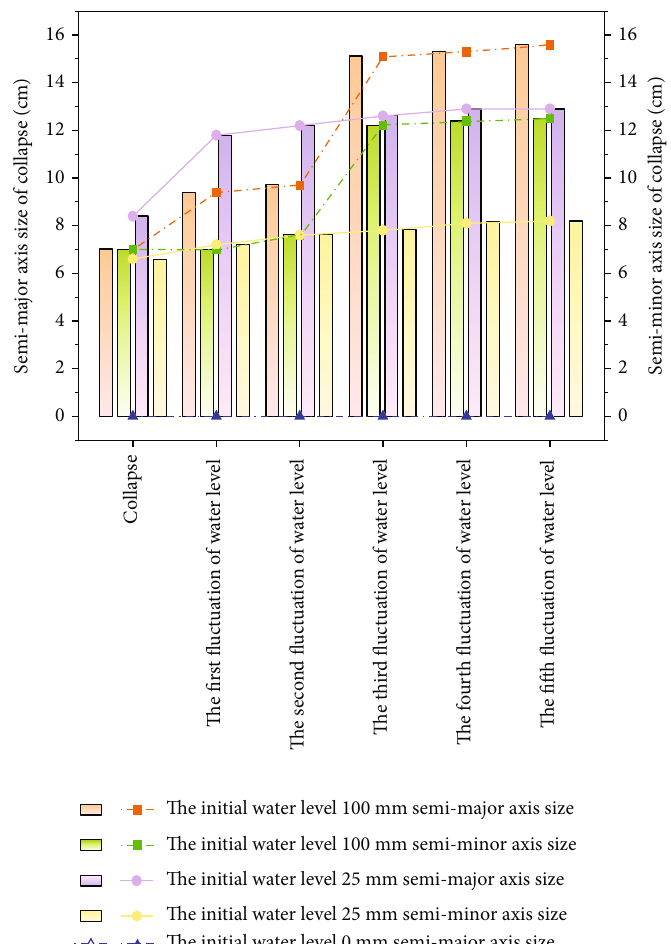
Figure 10: The number of water level fl uctuations and the semiaxis length of the collapsed (2) The di ffi culty of soil cave collapse negatively corre- 4.3. In fl uence of Initial Water Level and Number of Water lates with the initial water level. When the initial Level Fluctuations on the Deformation Overlying Soil. Water water level height is 100 mm and 25 mm, the soil level fl uctuations often cause existing soil caves to collapse. cave collapses during the water level fl uctuation 7 and 18 times, respectively, but it does not collapse when it is 100 mm. The height of the initial water level directly a ff ects the airtightness of the overbur- Figure 9 can be analyzed as follows: den layer and thus changes the hydrodynamic condi- (1) The time response of soil exfoliation to the initial tions. The higher the initial water level, the stronger water level is di ff erent. The time response speed is pos- the water sealing e ff ect and the better the internal itively correlated with the initial water level height. airtightness of the soil body, which enhances the The higher the initial water level, the more soil exfoli- water hammer gas explosion and negative pressure ation can occur when the frequency of water level fl uc- absorption e ff ect on the overlying soil layer. It accel- tuation is less, and the faster the slump at the cave ’ s erates the soil exfoliation and makes the soil cave roof is accumulated. When the initial water level more likely to collapse height is 100mm, there are two times water level fl uc- tuations, and local slumps occur in the overlying soil (3) The number of water level fl uctuations a ff ects the body of the existing soil cave. When the initial water amount of exfoliation of the overlying soil in the level height is 0mm, only a tiny amount of soil col- existing soil cave. The cumulative amount of slump lapses after fi ve times water level fl uctuations. The on the roof of the cave increased most obviously at response time and slump amount are not as good as the moment of collapse. With the increase in the the higher initial water level number of water level fl uctuations, the cumulative